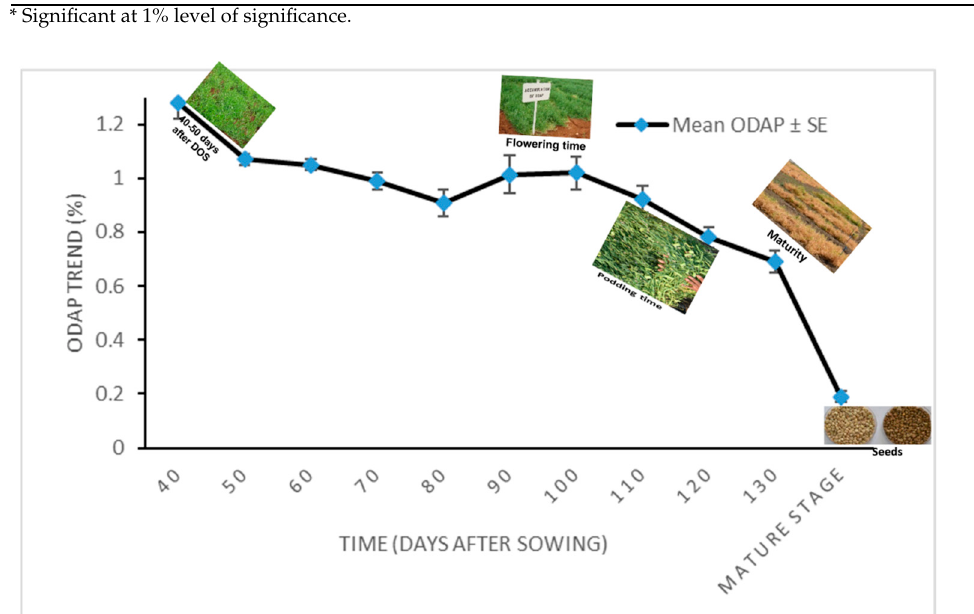
Figure 2. Mean leaf total ODAP content during different time points of sampling of tested Lathyrus accessions grown during 2011–2012 at Tel Hyada. Y axis presents leaf total ODAP content in percent, X axis denotes Time. Time points were: 1 = 40 DAS, 2 = 50 DAS, 3 = 60 DAS, 4 = 70 DAS, 5 = 80 DAS, 6 = 90 DAS, 7 = 100 DAS, 8 = 110 DAS, 9 = 120 DAS, 10 = 130 DAS, and 11 = mature stage (seeds). Table 6. Mean total ODAP content during different plant development stages in five accessions of grass pea during 2011–12.